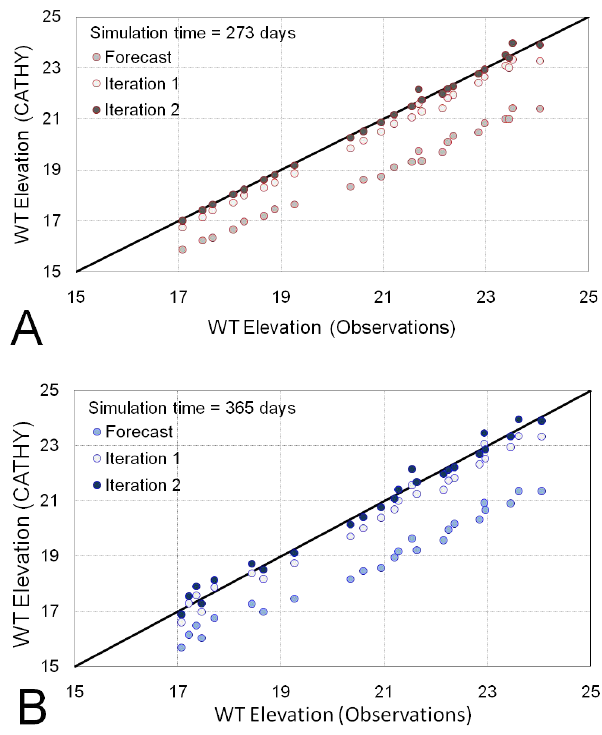
Fig. 17. Comparison between model-calculated WT values and ob- served WT data from the true system for the forecast WT ensemble, the WT ensemble generated using the updated GM parameter val- ues from the 1st iteration, and the WT ensemble using the updated GM parameters from the 2nd iteration. Comparison are made for (A) time=273 days and (B) time=365